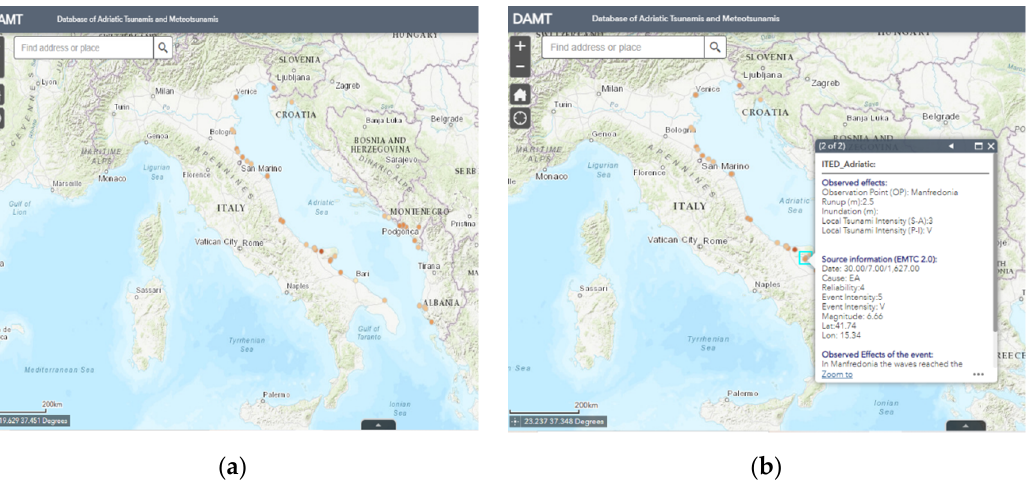
Figure 4. ( a ) Geographical distribution of the Tsunami Observation Points (ATOP layer). ( b ) An example of the pop-up for the Manfredonia (Apulia) observation point.